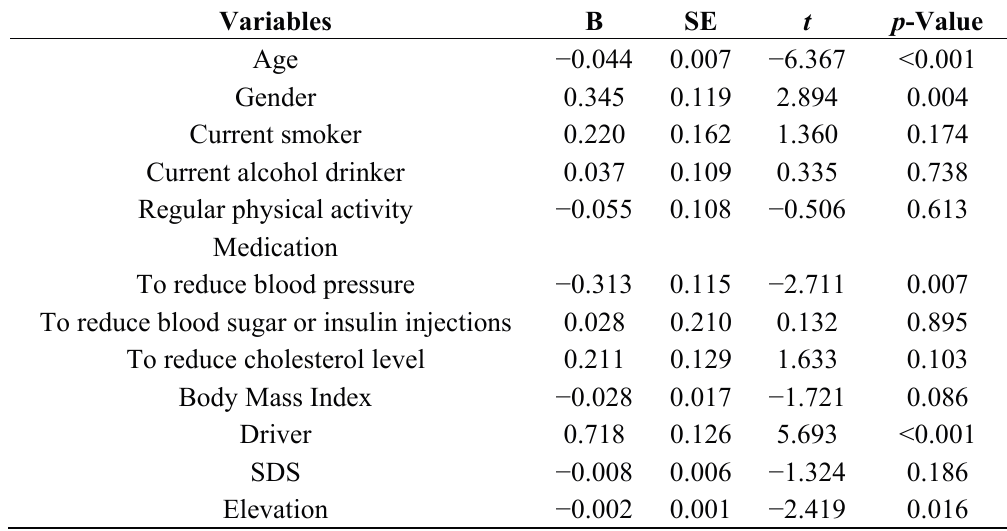
Table 2. Multivariable linear regression analysis with cognitive function as dependent